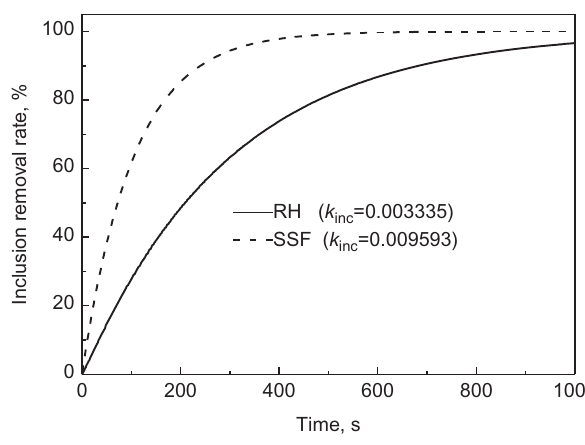
Figure 6: Variation of inclusion removal rate with